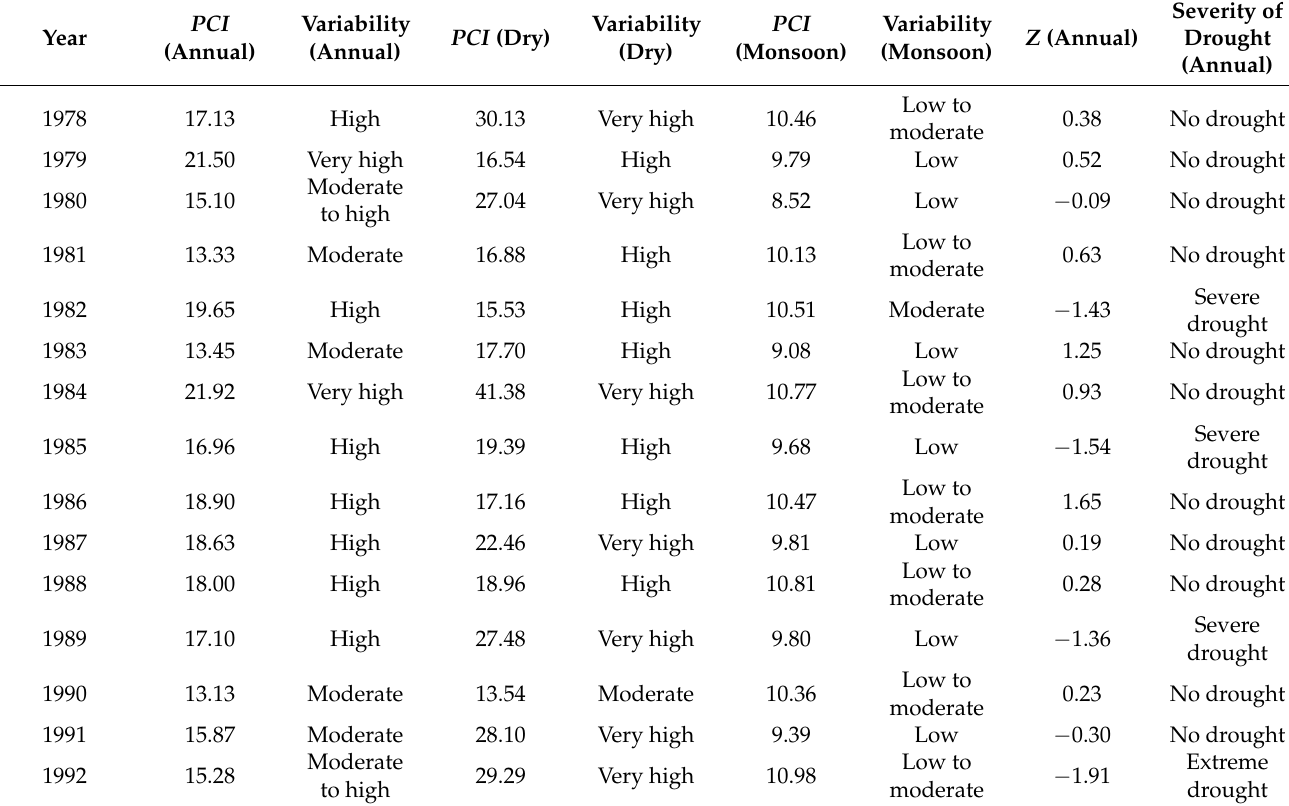
Figure 4. Standardized anomaly ( Z ) in seasonal rainfall at Khulna (1978–2017). Table 4. PCI and Z values of rainfall over the period of 1978–2017 at